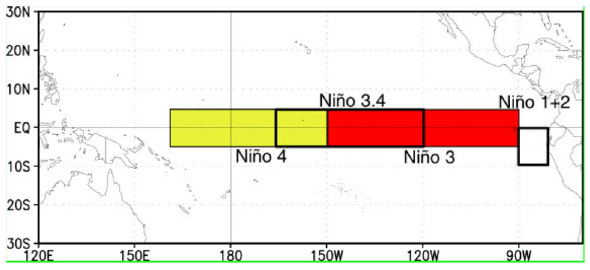
Fig. 1 The five regions across the equatorial Pacific. Source CPC